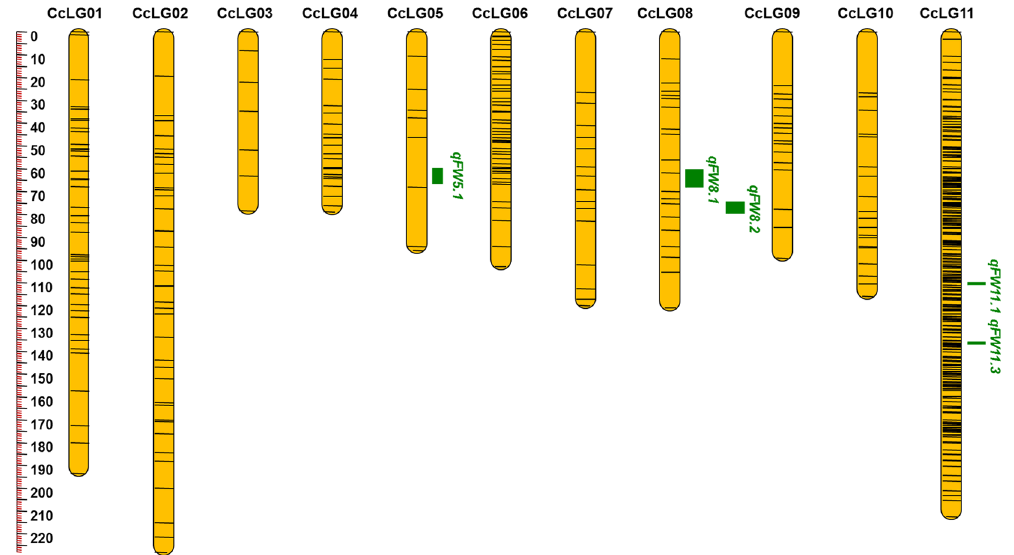
Figure 3. SNPs- based genetic linkage map and distribution of QTLs associated with FW resistance in F 2 mapping population (ICPL 85063 × ICPL 87119). The scale is on the left indicating genetic distance (centi Morgan; cM as unit). The black lines in the linkage groups represent the genetic position of the markers. Three linkage groups namely, CcLG05, CcLG08 and CcLG11 possess five QTLs for FW resistance. QTLs for FW resistance were represented as a vertical bar in green